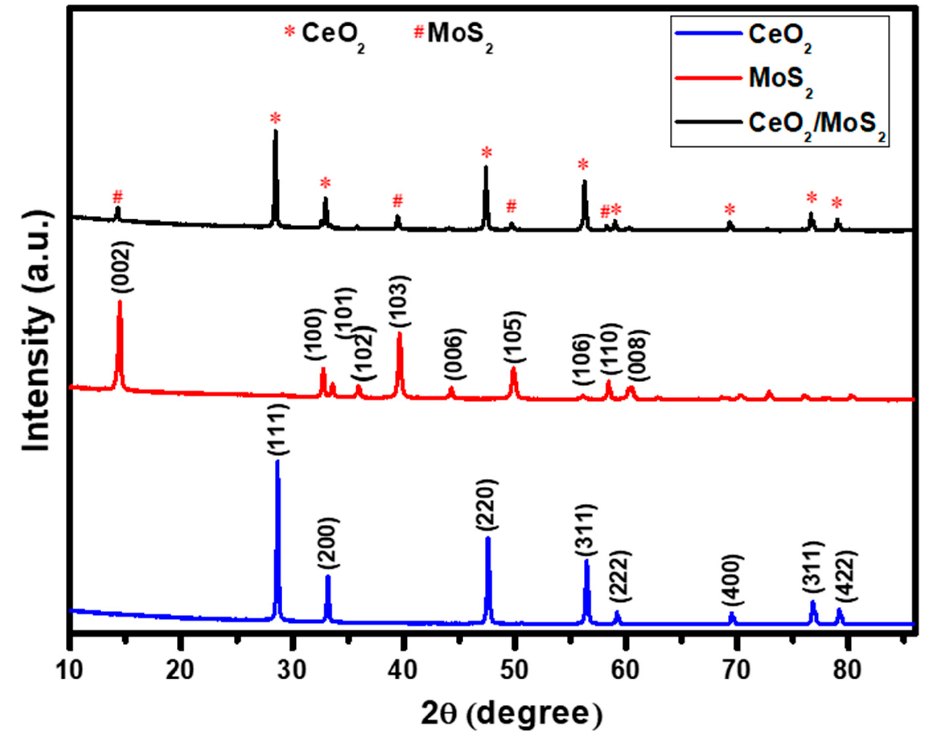
Figure 1. X-ray diffraction patterns of CeO 2 , MoS 2 , and CeO 2 /MoS 2 composite.